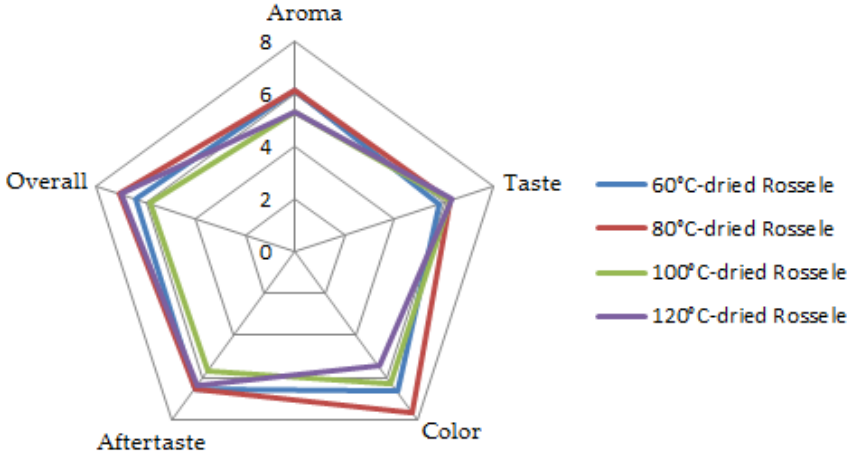
Figure 5. Sensory characteristics of the Roselle tea dried at different temperatures.